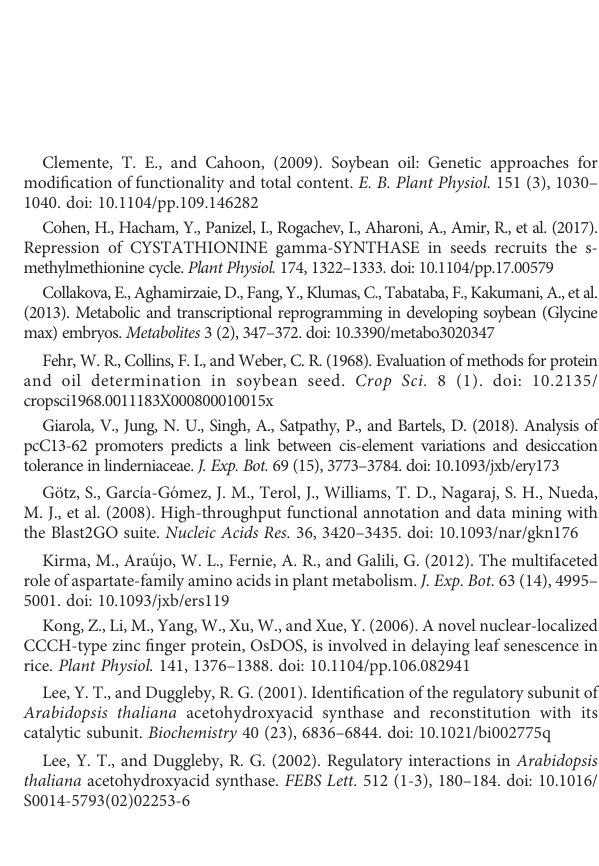
SUPPLEMENTARY FIGURE 1 KEGG enrichment analysis of the differentially accumulated metabolites through the comparative analysis. SUPPLEMENTARY FIGURE 2 KEGG enrichment analysis of the differentially expressed genes in NPS233 and NPS301. SUPPLEMENTARY FIGURE 3 Dynamics of gene expression during soybean seed development. SUPPLEMENTARY FIGURE 4 KEGGclassi fi cationandenrichmentanalysis ofthedifferentiallyexpressed genes from the K-means cluster 2 and